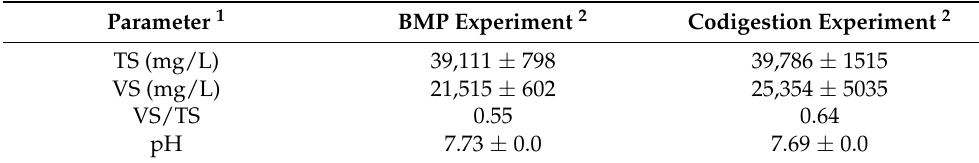
Table 1. Anaerobic inoculum characteristics.